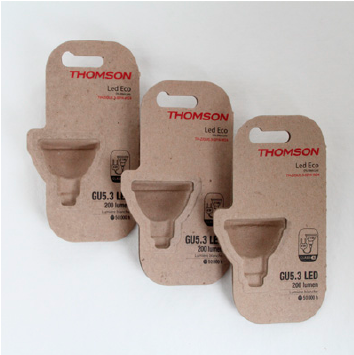
Figure 19. Electronic packaging for lamp bulb is made of recycle paper pulp [120].